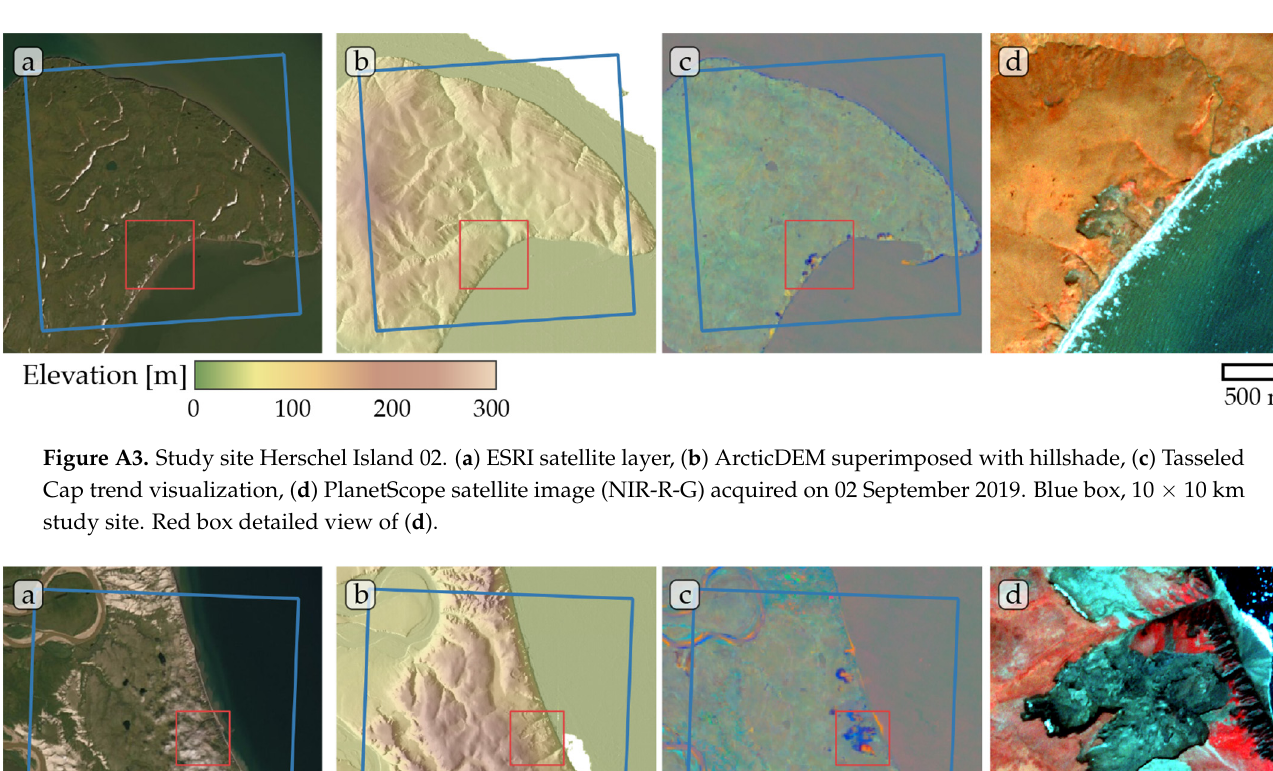
Figure A2. Study site Banks Island 02. ( a ) ESRI satellite layer, ( b ) ArcticDEM superimposed with hillshade, ( c ) Tasseled Cap trend visualization, ( d ) PlanetScope satellite image (NIR-R-G) acquired on 27 July 2019. Blue box, 10 × 10 km study site. Red box detailed view of ( d ).